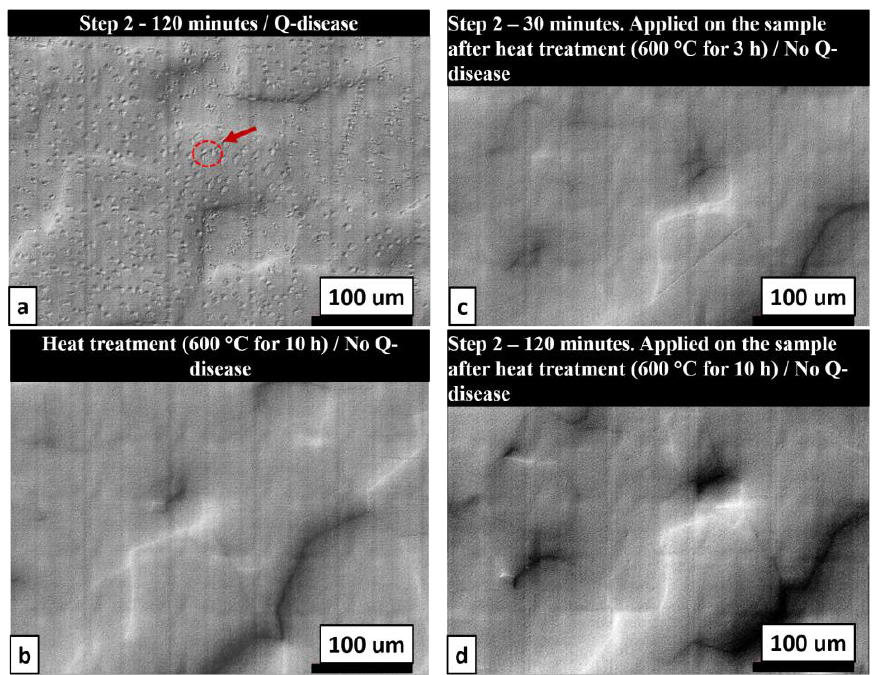
Figure 18. Photographs of niobium surface after nitrogen soaking after a full MP process ( a ), after heat treatment ( b ), and additional step-2 polishing ( c , d ). Note: Footprints are only visible on the first image. Arrow indicating the red circle is an example of a hydride footprint.